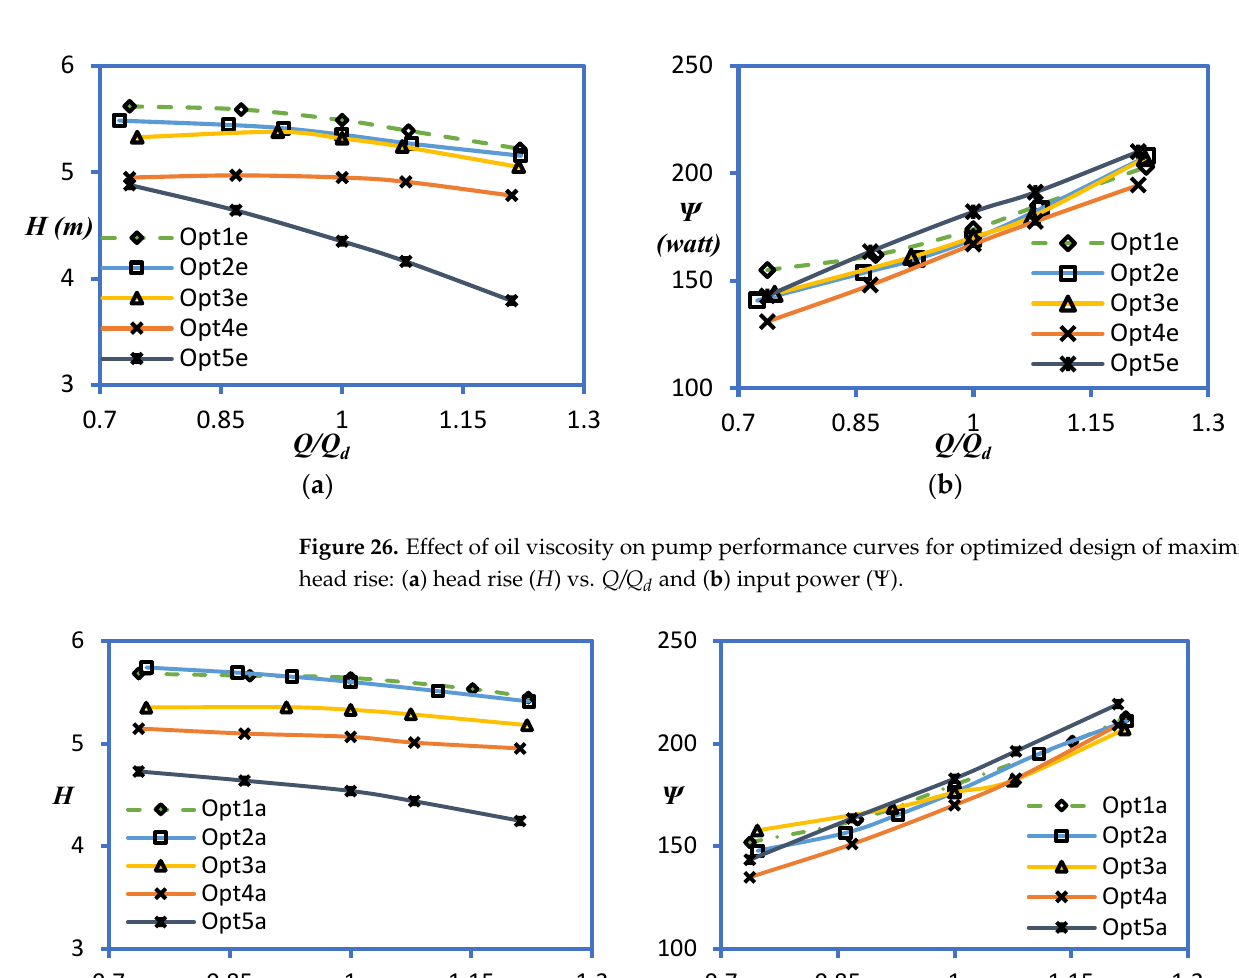
Figure 25. Effect of oil viscosity on pump performance for reference design: ( a ) head rise ( H ) vs. Q/Q d and ( b ) input power ( Ѱ ).